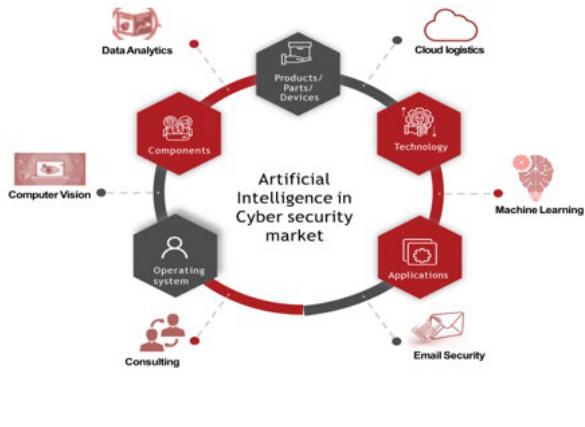
Figure 1. Usages of Artificial